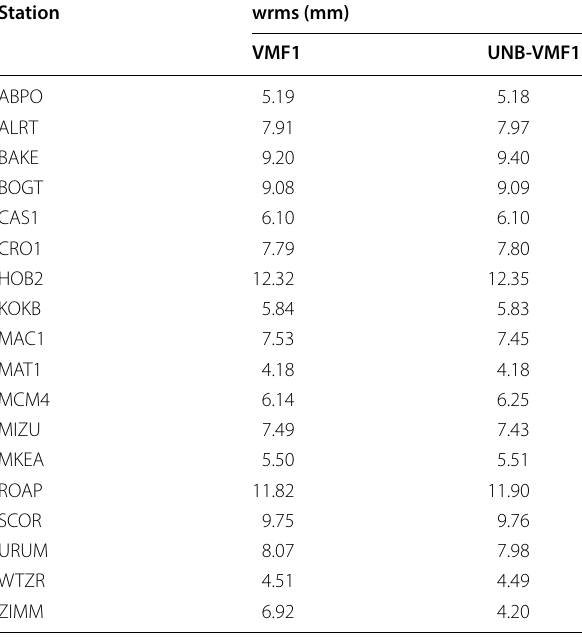
Table 4 GPS PDA stations height component